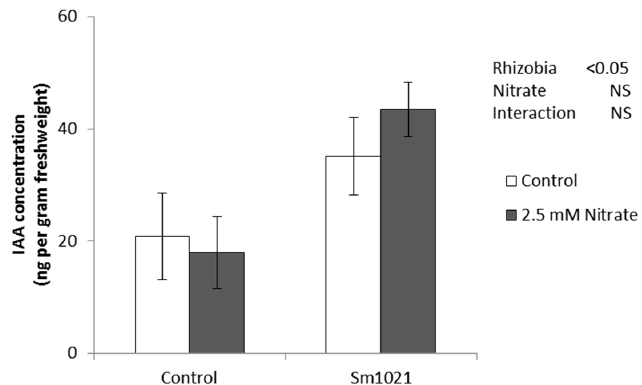
Figure 3. Quantification of auxin in roots in response to nitrate and S. meliloti treatment. Indoleacetic acid (IAA) quantification in 1 cm root segments surrounding the inoculation site at 24 h p.i. The histograms show the amount of auxin in mock-inoculated (Control) and S. meliloti -inoculated roots in the absence and presence of 2.5 mM nitrate. Two-way ANOVA showed a significant effect of inoculation ( p < 0.05), but not of nitrate (not significant, NS). Error bars represent standard error. Each measurement is comprised of five biological repeats with at least 30 root segments each.